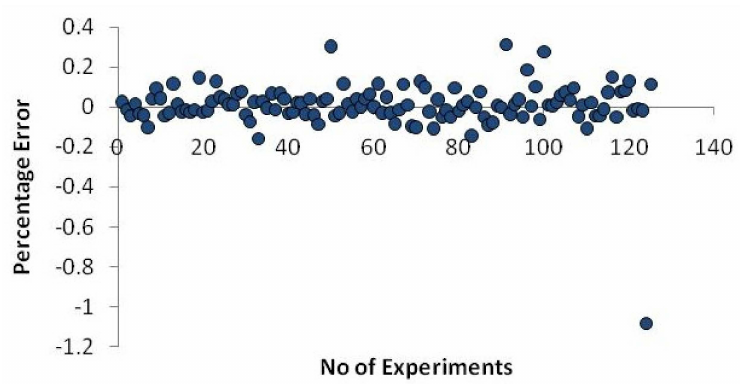
Figure 9. An angular distortion network 4-2-3 error graph demonstrating the time gap between two passes.